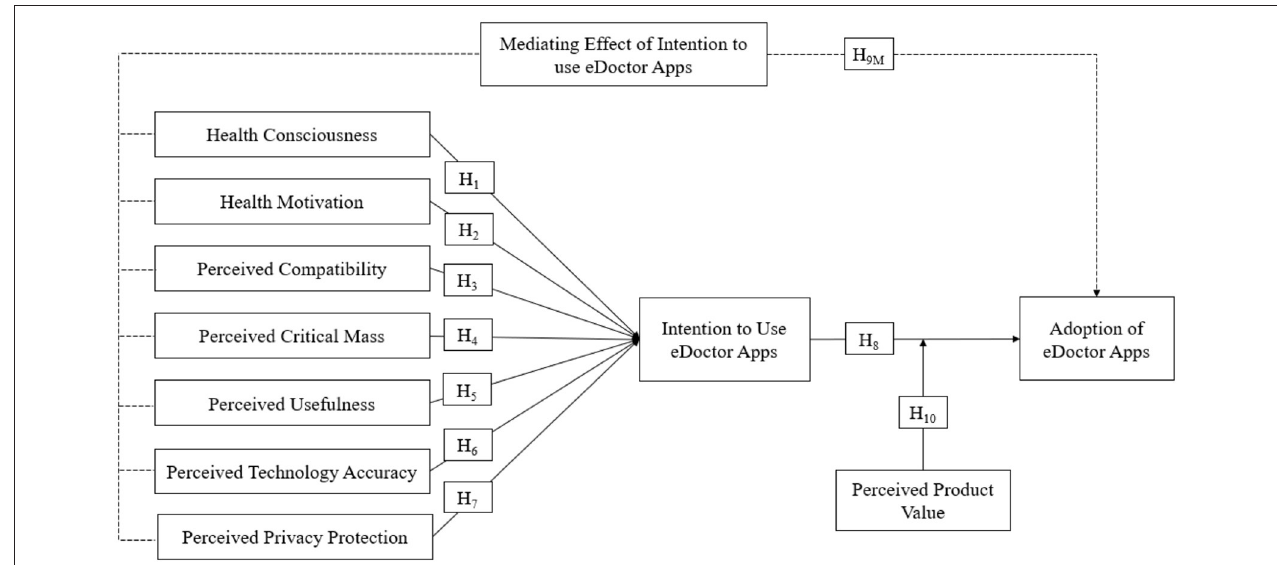
FIGURE 1 | Research